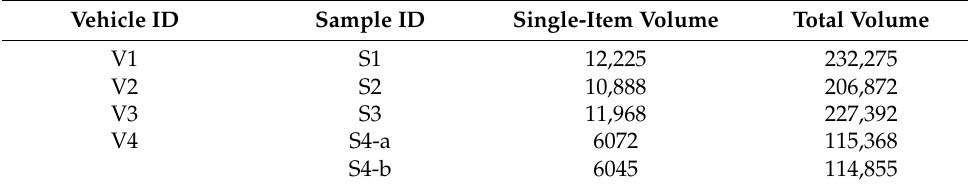
Table 3. Single-item volume and total volume of OBD data.